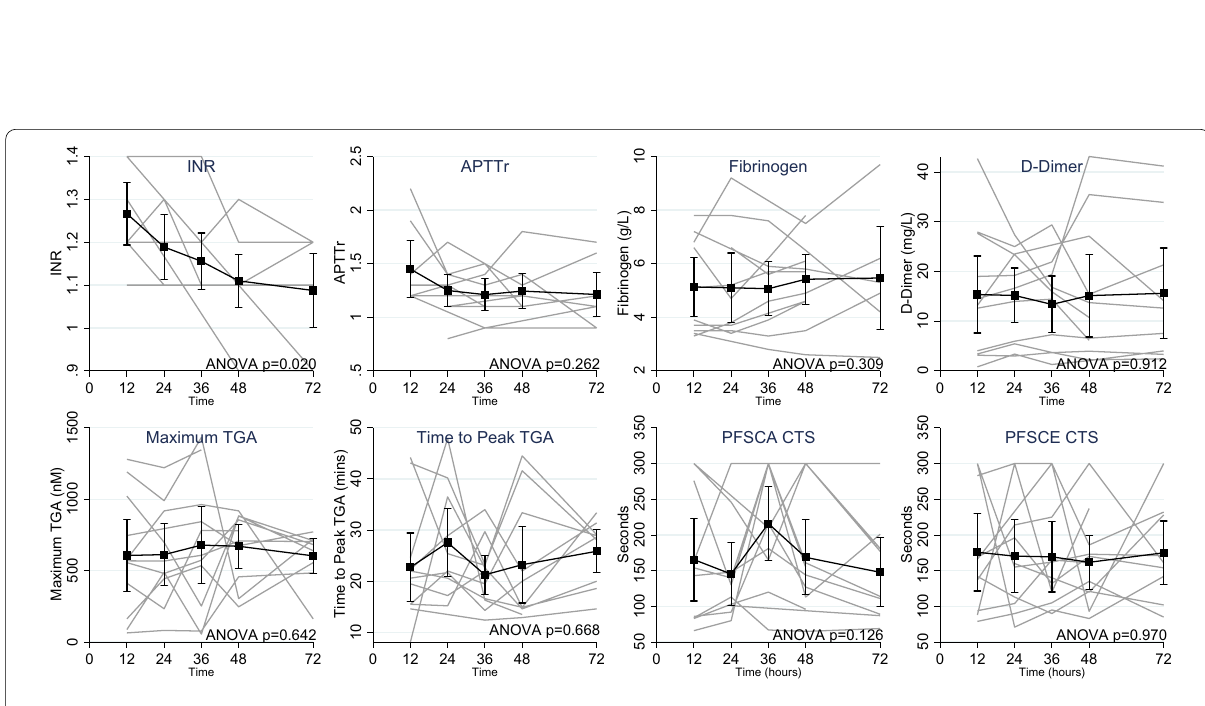
Fig. 3 Changes in circuit measurements of coagulation over duration of treatment. INR International Normalised Ratio, APTTr activated partial thromboplastin time ratio, TGA thrombin generation assay, PFSCA platelet function assay using collagen/adenosine diphosphate, PFSCE platelet function assay using collagen/epinephrine, CT closure time. Repeated measures ANOVAs of measurements from the circuit compared data from 12 to 48 h. Only INR differed overtime, with a significant difference between 12 and 48 h in post hoc comparisons ( p